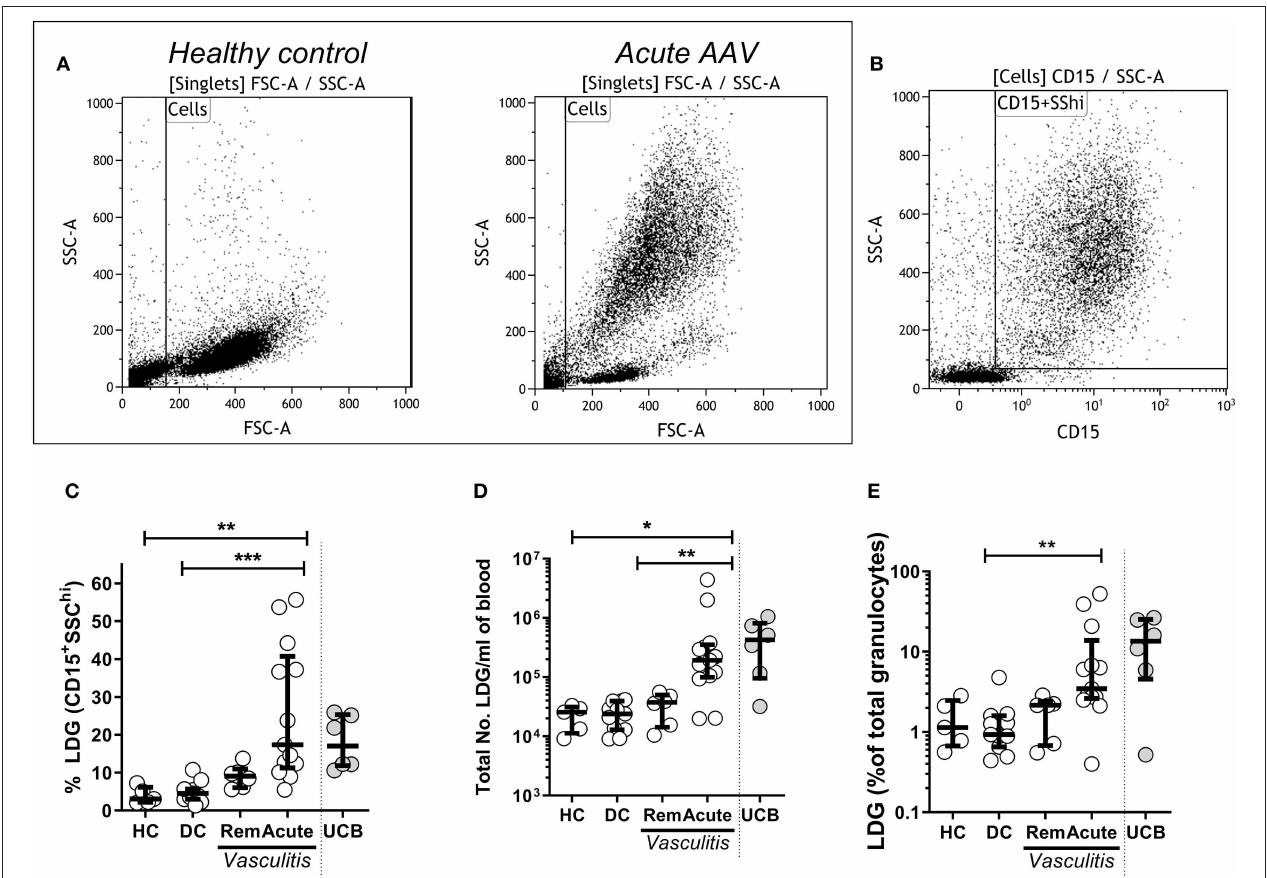
FIGURE 1 | Low density granulocytes (LDGs) are elevated in patients with Acute AAV. PBMC were isolated from peripheral blood of patients with AAV by density gradient centrifugation. Representative flow cytometry dot plots are shown from healthy control PBMC and acute AAV patient PBMC. (A) LDGs were classified as live SSC hi CD15 + singlets (data shown from a representative patient with acute AAV). (B) LDGs were quantified as the percentage of PBMC in the peripheral blood of 13 acute AAV patients, 6 remission (rem), 11 disease controls (DC), and 5 age matched healthy controls (HC). Each symbol represents an individual donor. The values from 6 samples of umbilical cord blood (UCB) are shown for comparison (C) . The absolute numbers of LDGs/mL of blood (D) and percentage of total granulocytes (E) were also quantified. Median with interquartile range. Kruskal-Wallis test, with post hoc analysis with Dunn’s multiple comparison. * p < 0.05, ** p < 0.01, and *** p <